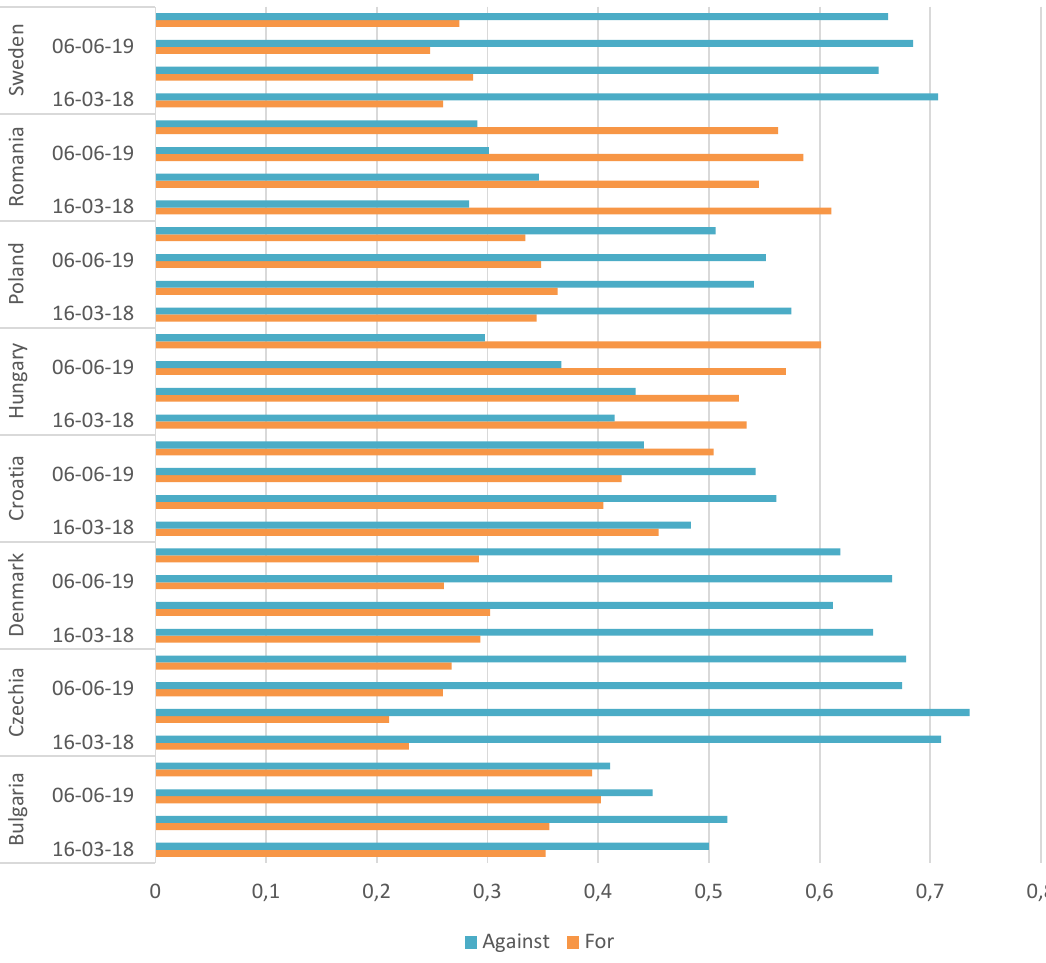
Figure 1. Sentiments regarding the EMU in selected EU non-euro area countries. Source: